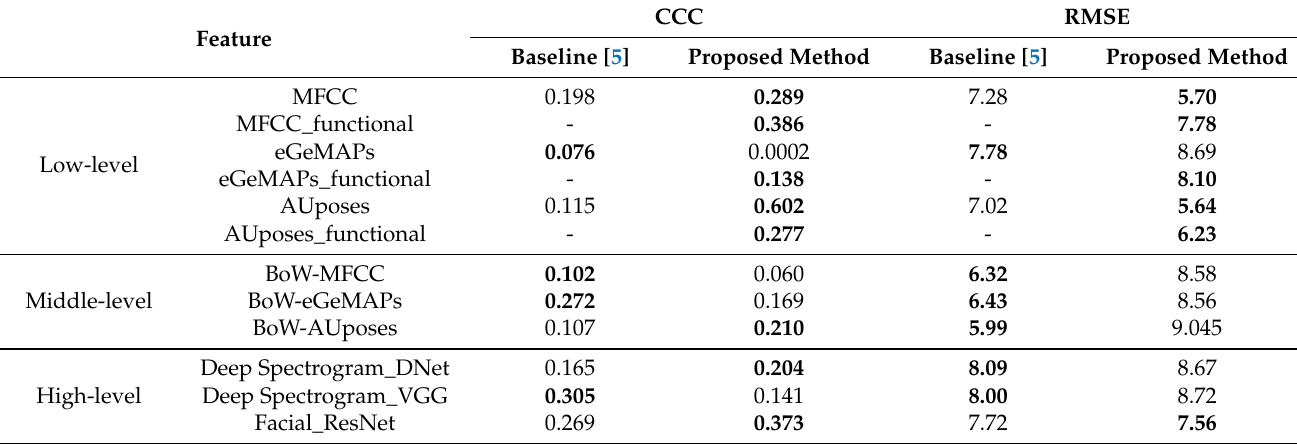
Table 2. Comparison between The GRU baseline model [5] and The Transformer-based model for different features from audio and video modality. For every kind of feature from each modality, we use two metrics including CCC and RMSE. The data in bold means the results with better performance.